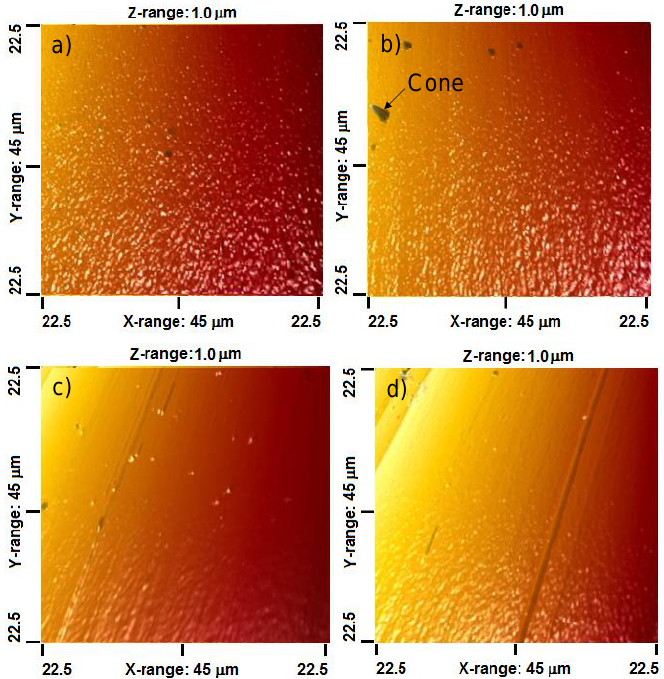
Figure 5. AFM images in 2D of the coatings, ( a ) Ti-W-N monolayer, ( b ) Ti-W-C monolayer, ( c ) n = 1, and ( d ) n = 40 multilayer coatings.